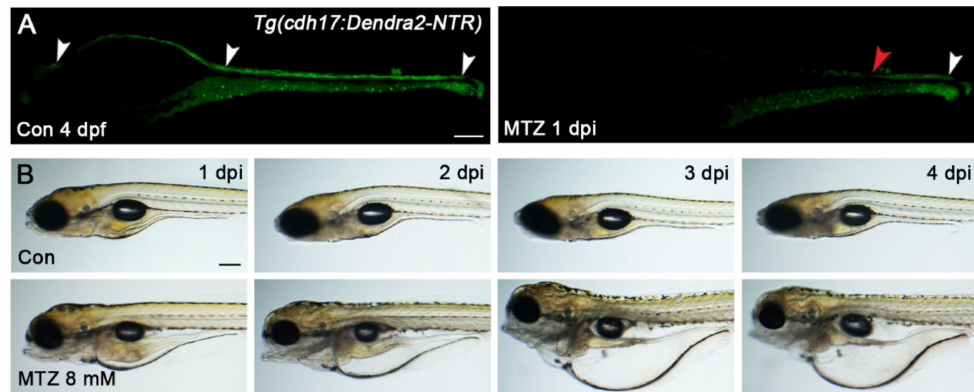
Figure 2. MTZ induces renal tubular epithelial cells-specific ablation. ( A ) Treatment with MTZ resulted in the attenuation of the Dedra2 signal in the renal tubules of Tg(cdh17:Dendra2-NTR) zebrafish larvae ( n = 30). The white arrowheads in Con larvae indicated the intact renal tubules (head, body and tail). The white and red arrowhead in MTZ larvae respectively indicated the remaining and the injured parts of the renal tubules. Scare bar: 100 µ m. ( B ) Edema could be seen in MTZ-treated Tg(cdh17:Dendra2-NTR) zebrafish larvae but not in the control at 1 dpi to 4 dpi ( n = 30). Scale bar: 200 µ m. Con, control. n, the number of larvae per group under each treatment condition. Each experiment was repeated more than three